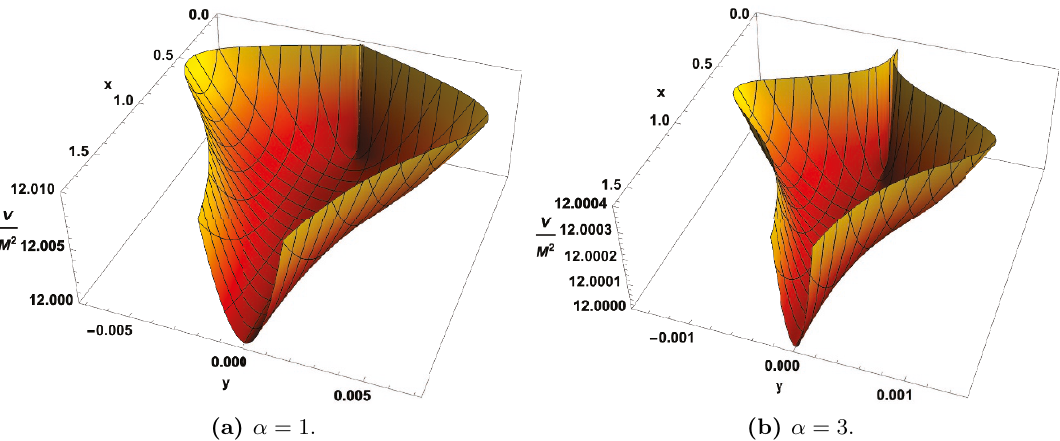
Figure 3. The effective scalar potential V ( x, y ) for the two values α = 1 (left panel) and α = 3 right panel, now stabilized by quartic terms in the imaginary direction with β =